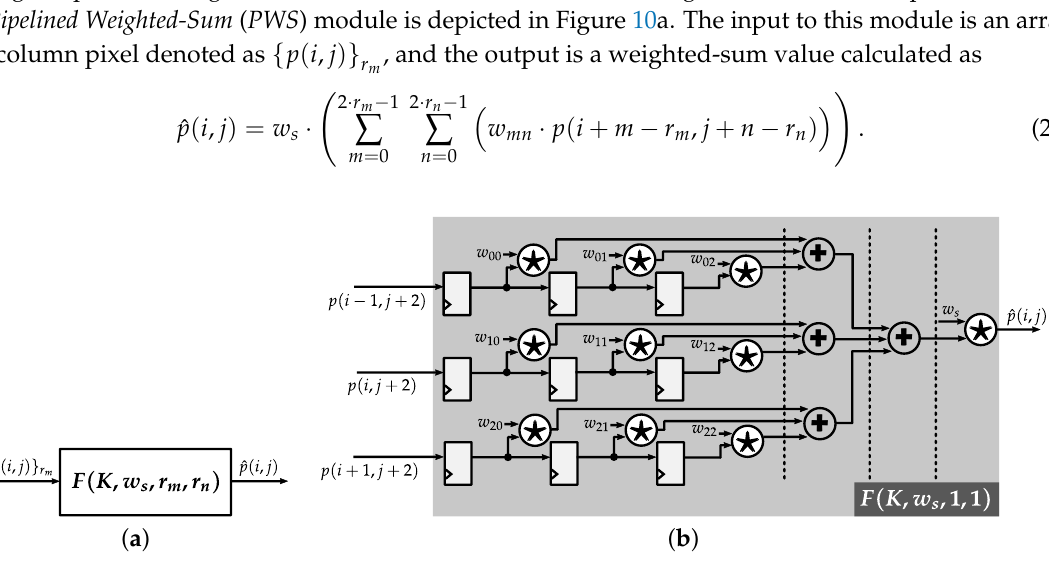
Figure 10. Pipelined Weighted-Sum (PWS) module. ( a ) Block representation. ( b ) PWS for 3 × 3 kernel. Dotted lines indicate possible pipeline cuts. The (cid:63)(cid:63)(cid:63) operator indicates customized shift-based